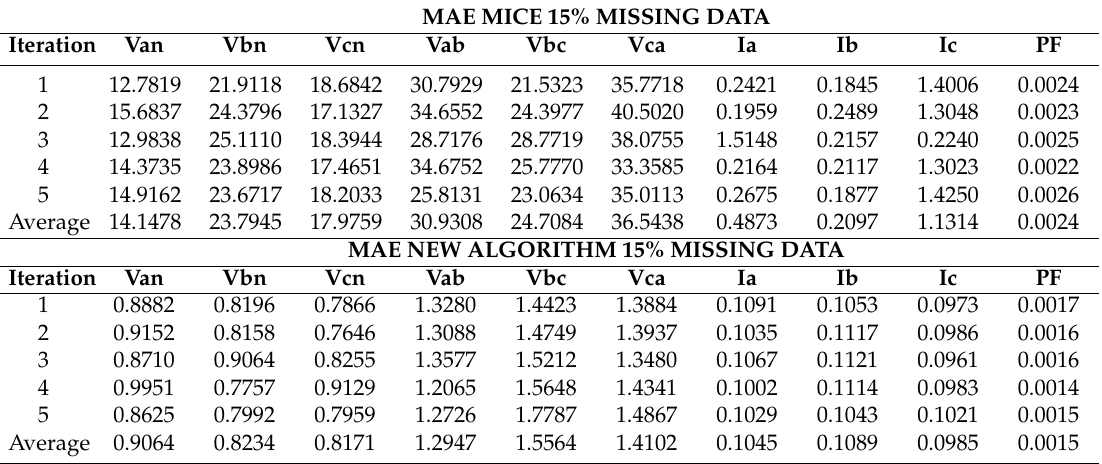
Table 8. MAE obtained with a 15% of missing data MICE and new proposed AAA package.